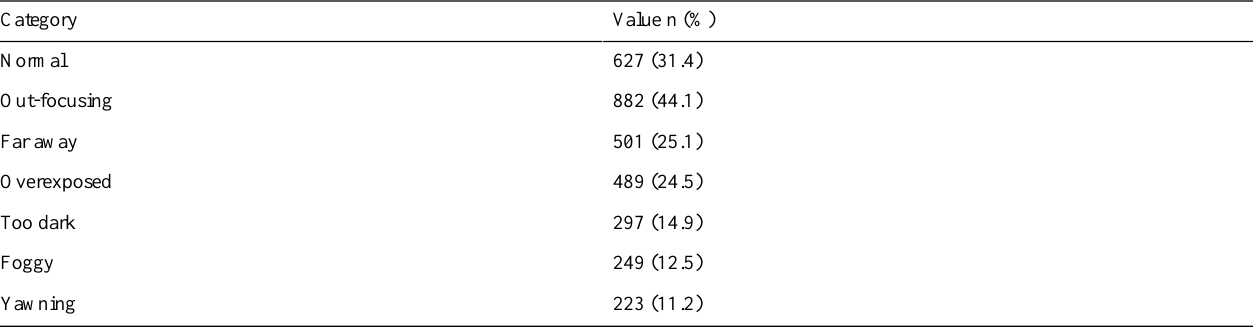
Table 1. Statistical results of the quality of the acquired